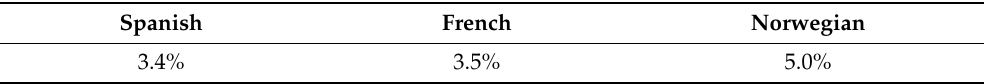
Table 11. NLG errors measured as the repetition request